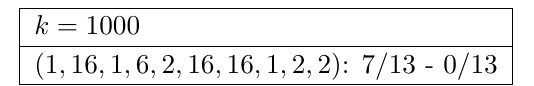
Table 7 . Kaq ness for L 24 on su (8) . Format is “ ( d i ) : Fraction of solutions with the pattern ( d i ) that were (partially- kaq ) - ( kaq )”. See remark 3.5 for partial- kaq .